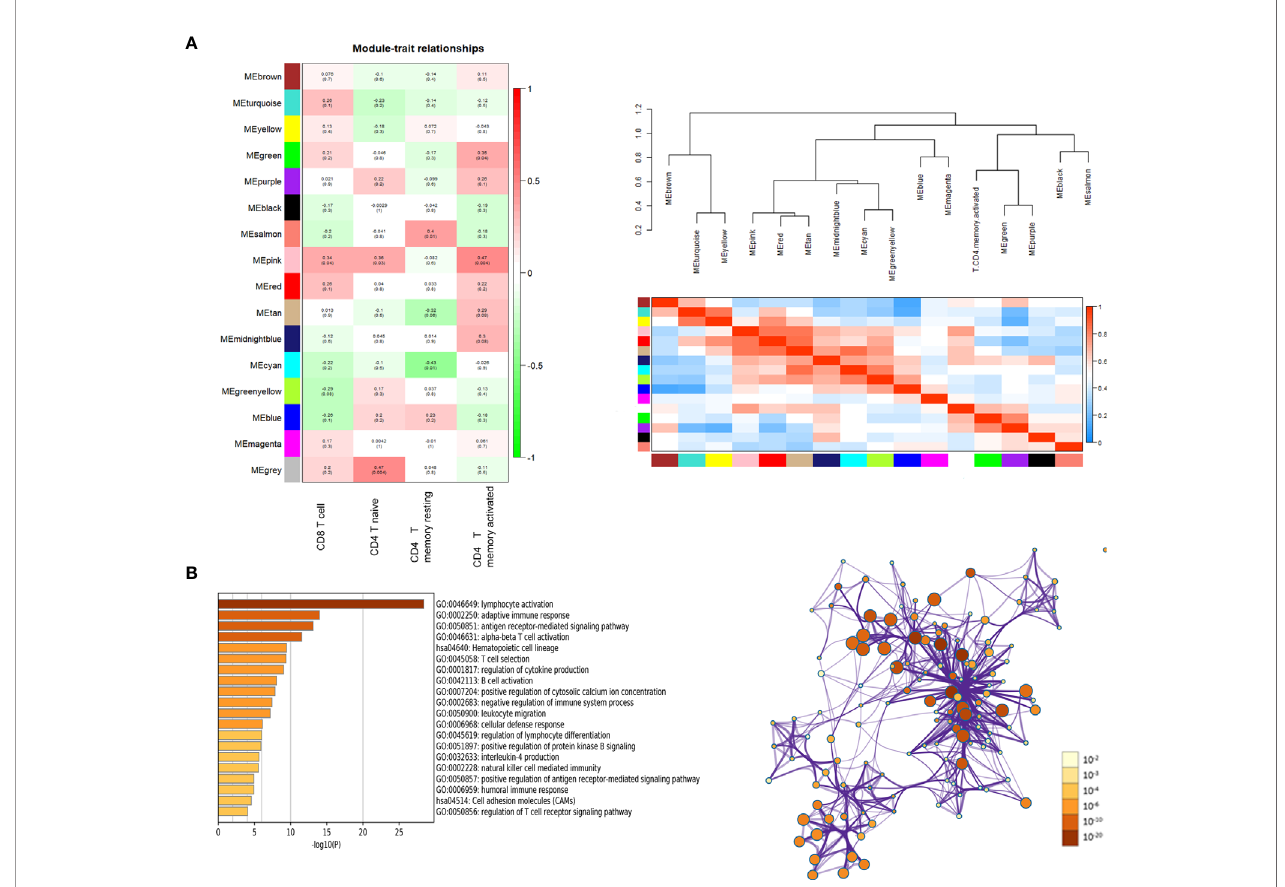
FIGURE 3 | Key modules and feature notes. (A) Heatmap and Eigengene-dendrogram show the correlations of module eigengenes with T-cell in fi ltration. (B) The fi rst 20 enriched terms are shown as a bar chart on the left. The protein – protein interaction networks diagram on the right is constructed with each enrichment term as a node and which colored by different cluster